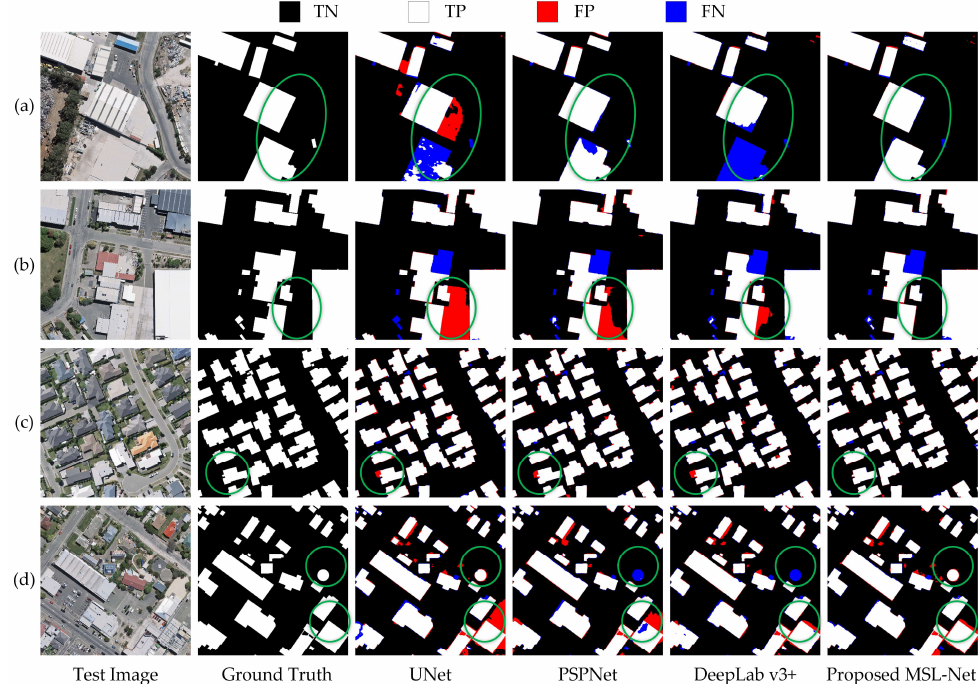
Figure 7. Examples of the segmentation results obtained using different methods. ( a – d ) Results selected from the WHU dataset.